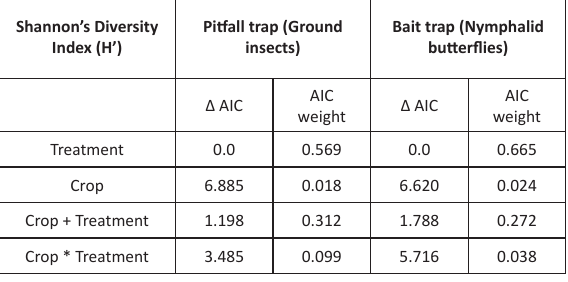
Table 1. Model selection results for factors affecting diversity of overall ground insects and nymphalid butterflies. The best model is included in boldface font.